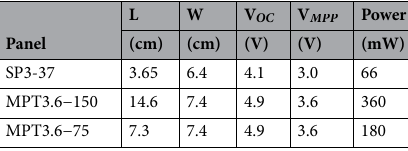
Table 2. PV Panel